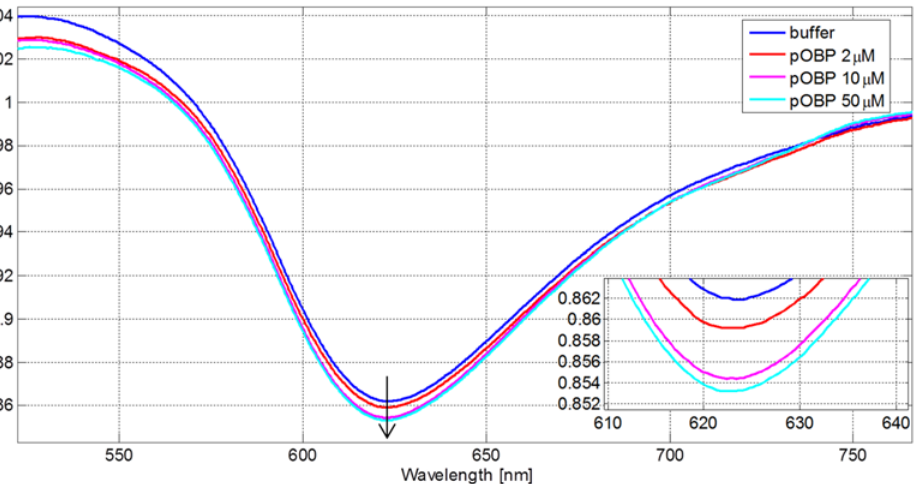
Fig 5. Control — SPR experimental results. SPR transmission spectra, normalized to the air spectrum, for different pOBP concentrations in the case of the reference sensor with gold layer — SAM without bio-receptor. Inset: Zoom of the resonance wavelengths